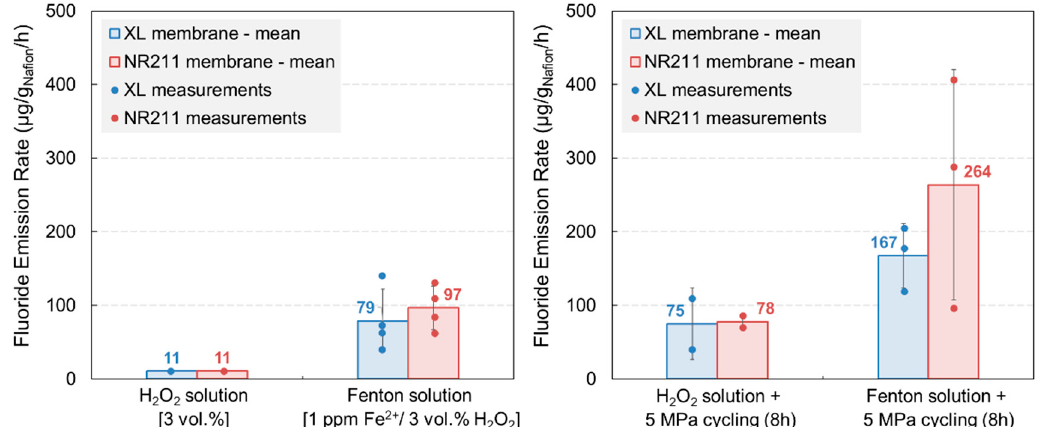
Figure 2. Fluoride emission rates (FER) of Nafion™ XL and NR211 membranes after chemical aging (to the left) and after chemical-mechanical aging (to the right).